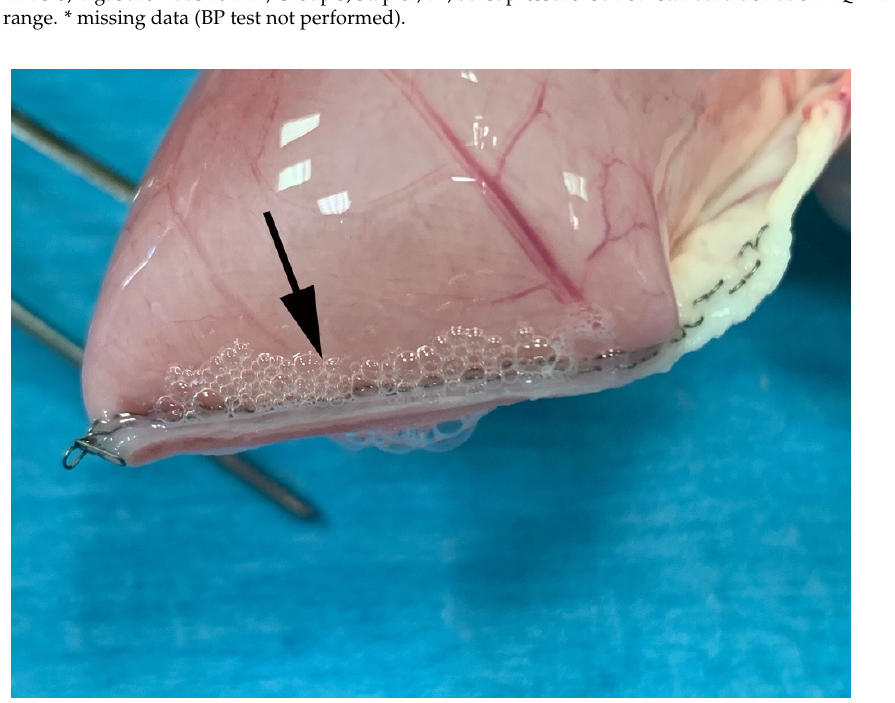
range. * missing data (BP test not performed).